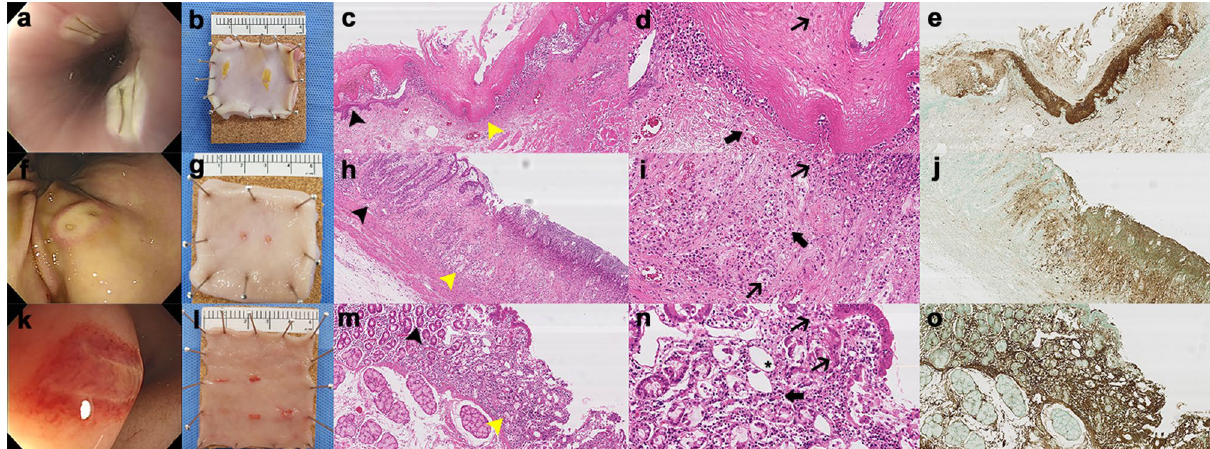
Figure 5. Endoscopic, gross inspection, and histopathology views after irreversible electroporation (IRE) in the phase 2 study. The first row represents the esophageal ablation effect at 1500 V (717.7 V/cm), the second row is the result of ablation of the stomach at 1000 V (1000 V/cm), and the third row shows the duodenal ablation results at 1000 V (478.5 V/cm). First column: endoscopic view immediately after IRE ablation of ( a ) esophagus, ( f ) stomach, and ( k ) duodenum. Second column: tissue gross inspection 24 h after IRE ablation of ( b ) esophagus, ( g ) stomach, and ( l ) duodenum. Third column: hematoxylin and eosin staining of electroporated ( c ) esophagus, ( h ) stomach, and ( m ) duodenum (black arrowhead; non-ablated area, yellow arrow head; ablated area). Hematoxylin and eosin (H&E), 100 × magnification. Fourth column: magnified (× 300) H&E staining of ( d ) esophagus showing epithelial karyolysis (thin arrow) and some pyknotic nuclear changes in the submucosa (thick arrow), ( i ) stomach showing a fragmented nucleus, karyorrhexis (thin arrow) and pyknotic nucleus (thick arrow), and ( n ) duodenum presenting karyolysis (thin arrow) in the form of nucleus and some pyknotic nucleus (thick arrow) with glandular atrophy (*). Fifth column: terminal deoxynucleotidyl transferase dUTP nick-end labeling assay of ( e ) esophagus, ( j ) stomach, and ( o ) duodenum. H&E: 100 ×